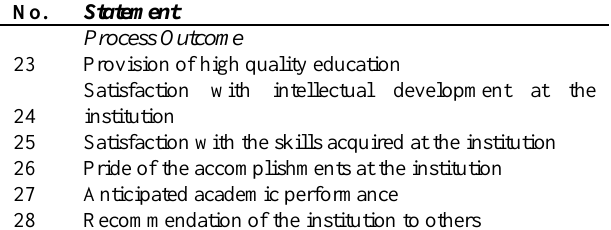
Table 1: Process Outcome